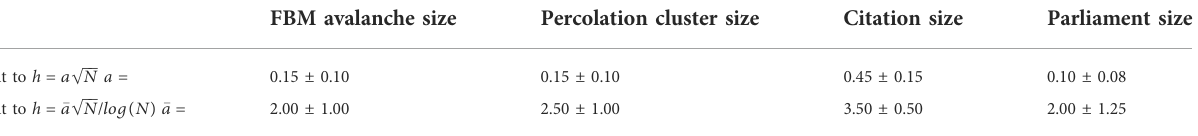
TABLE 1 Values of the pre-factors a and (cid:1) a for the h − index scaling fi ts. FBM avalanche size Percolation cluster